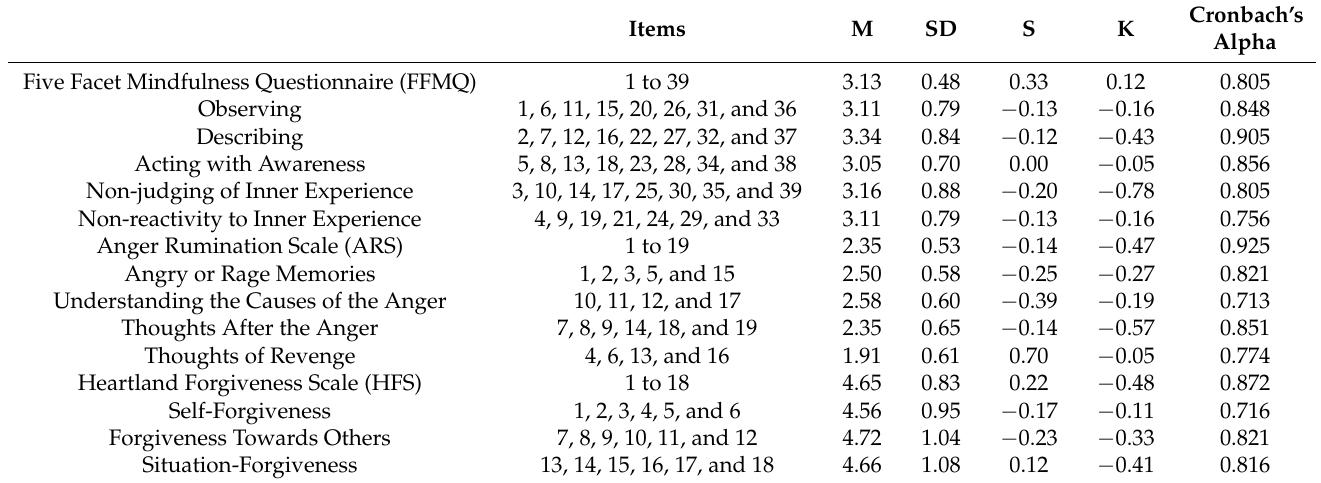
Table 1. Items, means, standard deviations, skewness, kurtosis, and reliabilities of